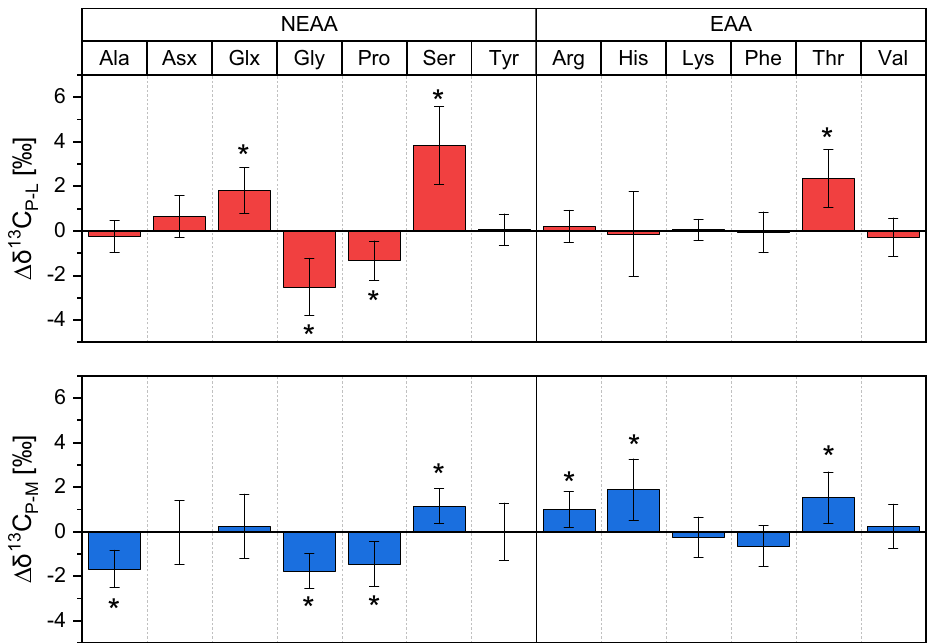
Figure 1. Average trophic fractionation (Δδ 13 C ± SD in ‰, n = 15) of individual AAs between parasite (P), host liver (L) and muscle (M) tissue over 90 dpi. Asterisks (*) indicate significant differences of average Δδ 13 C values from zero (two-sided t tests, DF = 14, p < 0.01). Trophic fractionation of EAAs between parasite and host liver was very low except for Thr, whereas significant Δδ 13 C P-M values between the parasite and muscle tissue of the EAAs Arg, His and Thr were observed. Δδ 13 C P-L values were negative for the NEAAs Gly and Pro and positive for Ser and Glx. Note that trophic fractionation of Asx and Glx between the parasite and muscle tissue seemed low and not significant, but regression slopes of δ 13 C values from Asx and Glx over time were very different between the two tissues (compare Table S3) and are therefore not directly